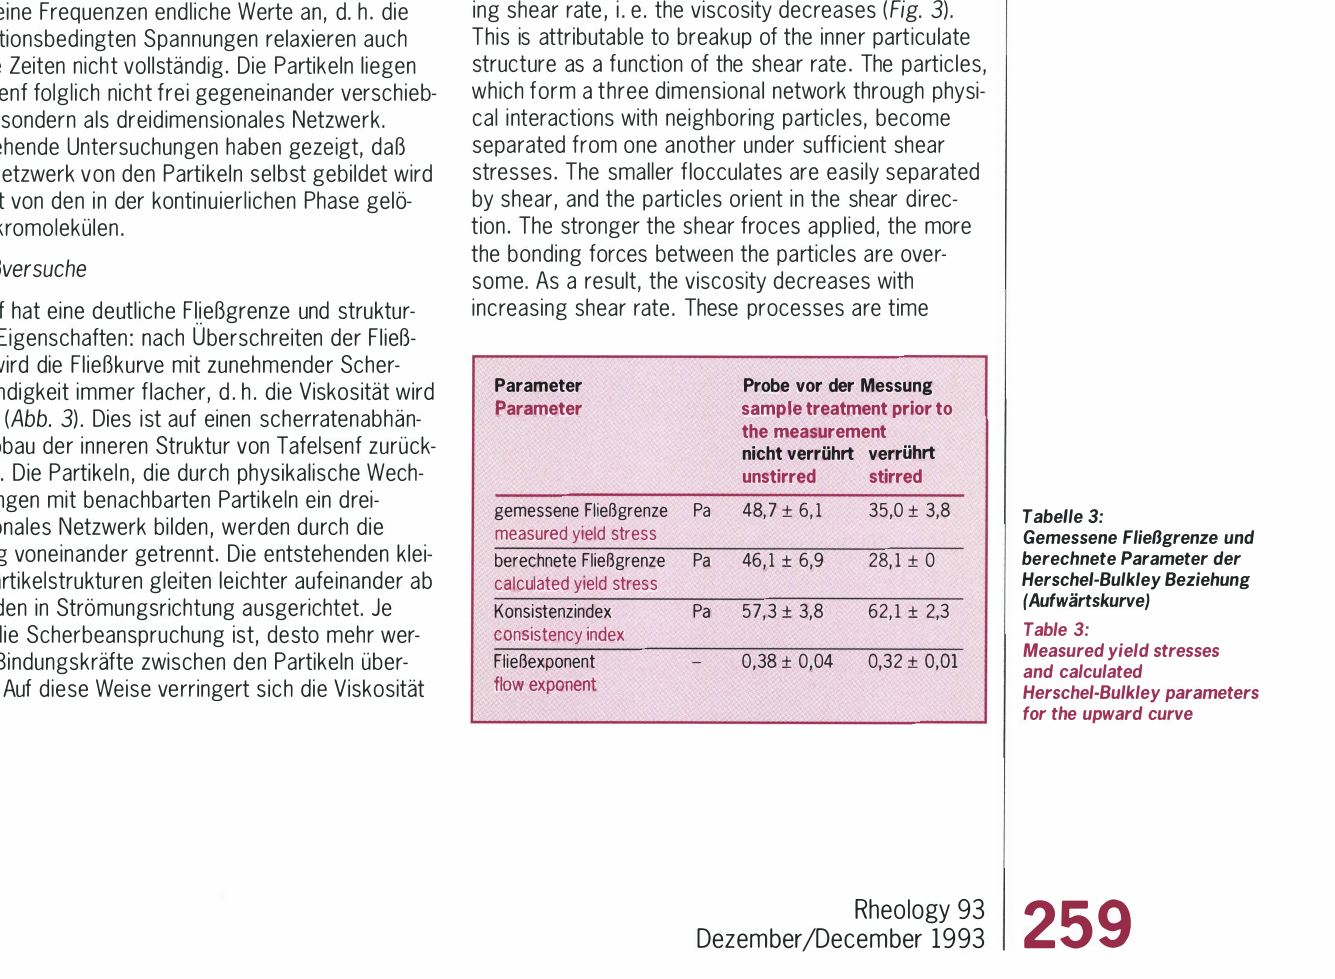
Abb. 3: Vergleich der Me/Jkurve und der nach Herschei­ Bulkley berechneten Kurve Fig. 3: Comparison of the measured flow curve and the curve calculated using the Herschei-Bulkley equation